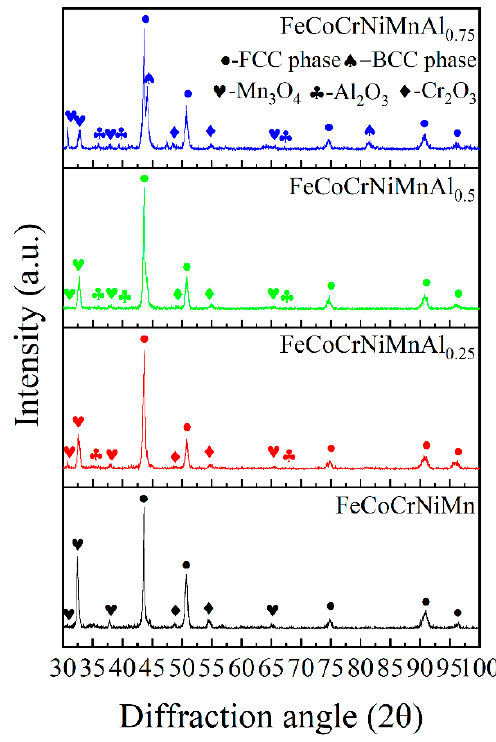
Figure 6. Phases in the oxidation layer of the FeCoCrNiMnAl x cladding layers after 100 h high- temperature oxidation.